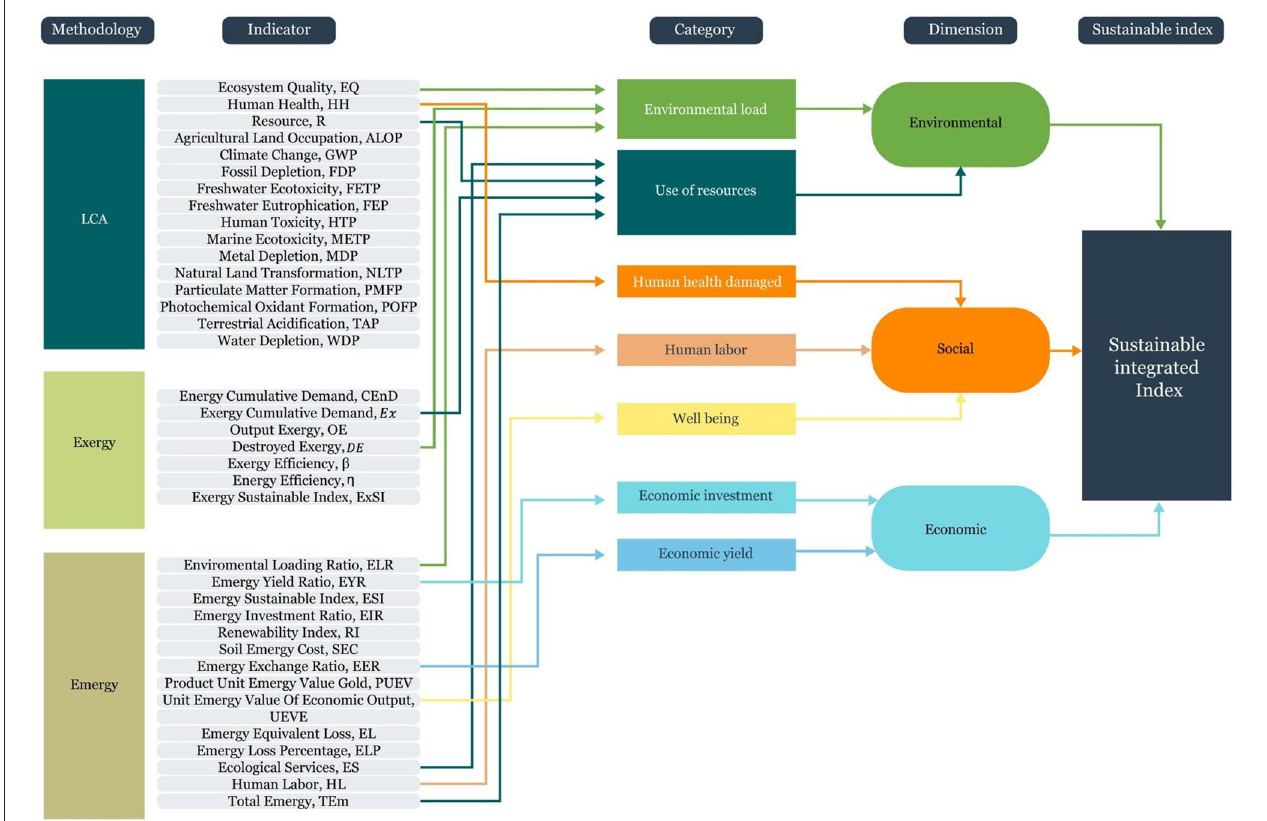
FIGURE 2 | Structural model of Integrated Sustainability Index (ISI) calculation from the integration methodology proposed in this research.